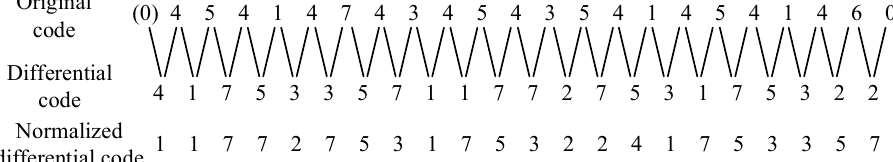
Figure 12. Calculation example of the normalized differential code of obstacle underwater image.